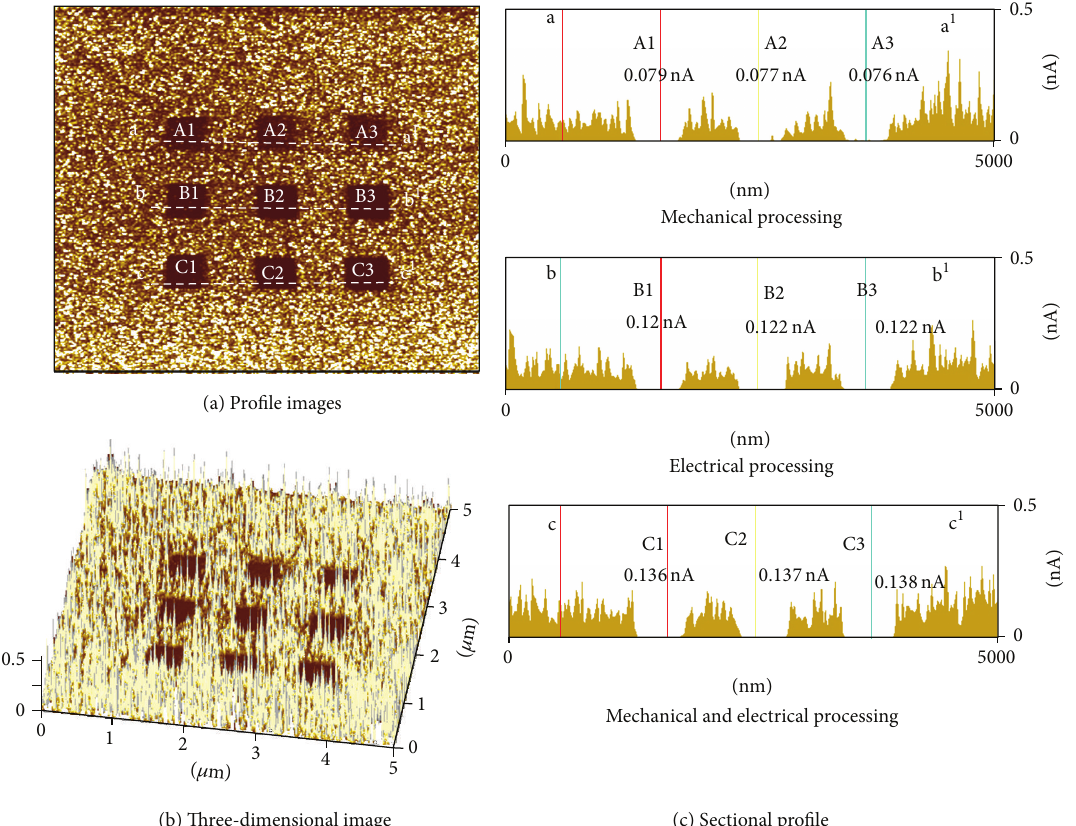
Figure 21: AFM current profiles and cross-sectional images of surfaces obtained by (a) mechanical, (b) electrical, and (c) electromechanical processing.